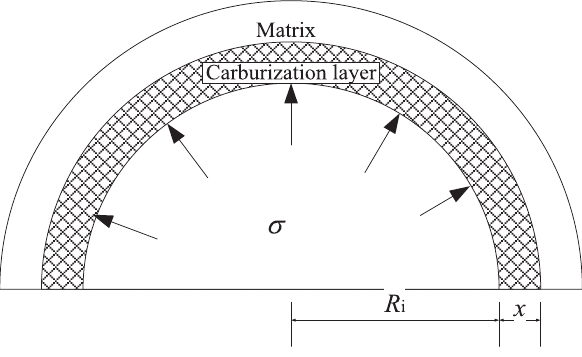
Fig. 2: Geometry mode of Cr25Ni35Nb alloy